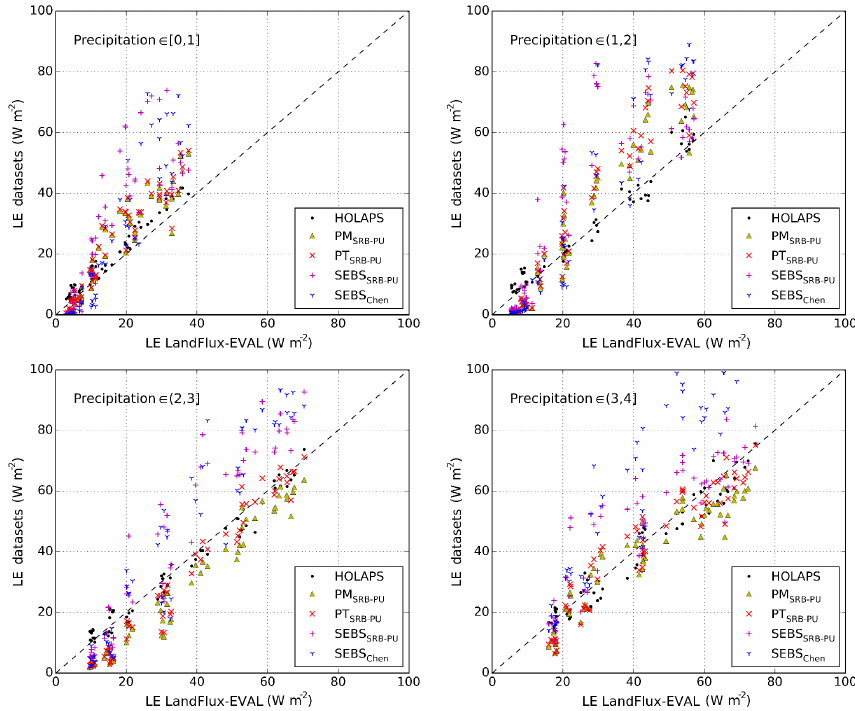
Figure 11. The monthly mean scatter plots of LE between the LandFlux-EVAL benchmark product and other products over different precip- itation thresholds.